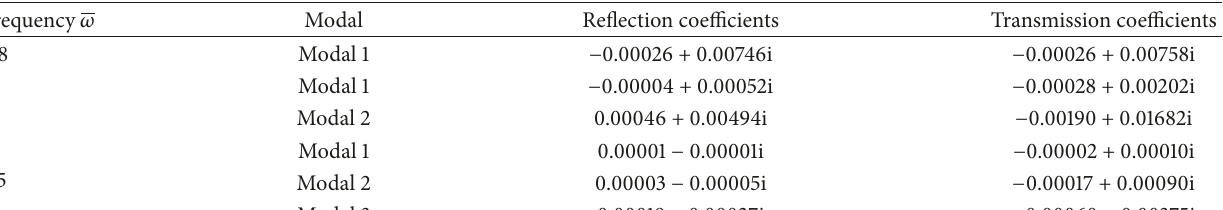
Table 3: The transmission and reflection coefficients with truncated locations at 𝑥 = ± 60 𝜆 𝐿 /𝐻 , 𝑅 2 = 0.2 , and 𝑑 = 0.5 ( 𝜆 𝐿 being the Love wavelength for the lowest mode) for a circle defect in half-plane.